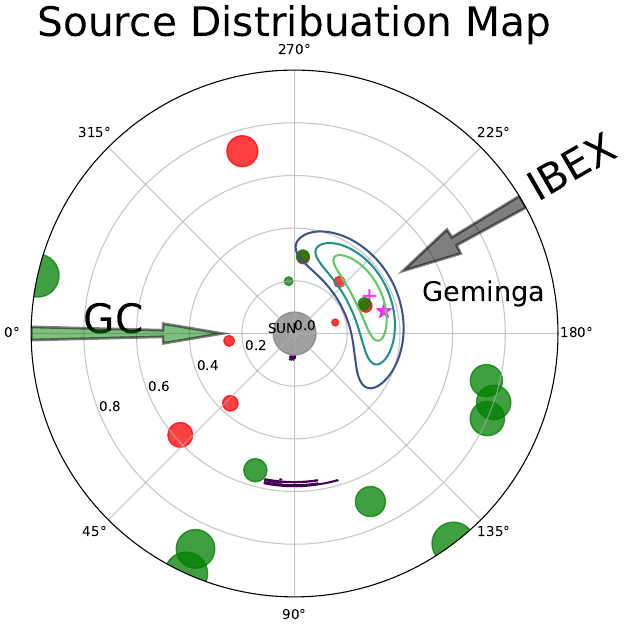
Figure 5. 2D contour of source distribution on galactic disk. The red spots indicate SNRs, green indicates pulsars, and the solid lines are 1- σ , 2- σ , and 3- σ contours, respectively. The black arrow is the direction of the LRMF, and the green arrow is in the direction of the galactic center. Where the purple cross is the mean of fit center, the star is in the Geminga-SNR